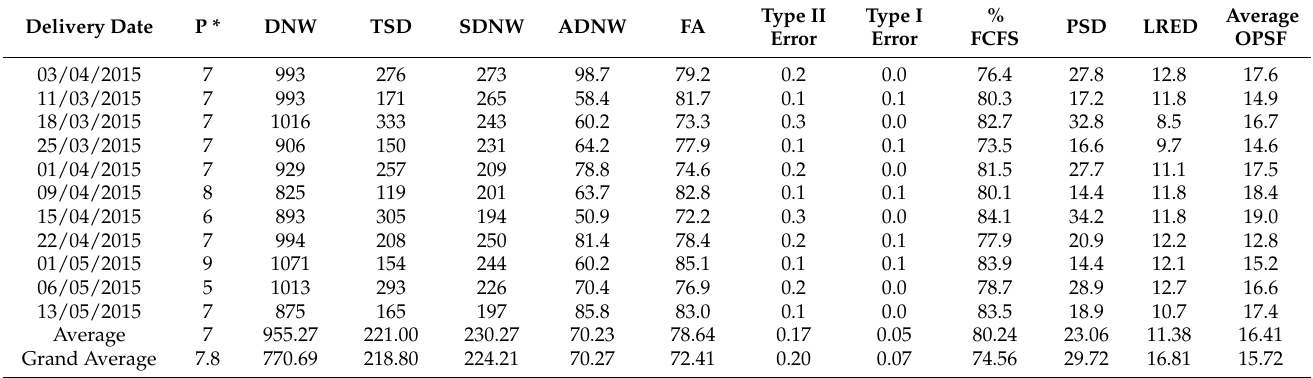
Table 1. The main results for 10 weeks plus the grand average